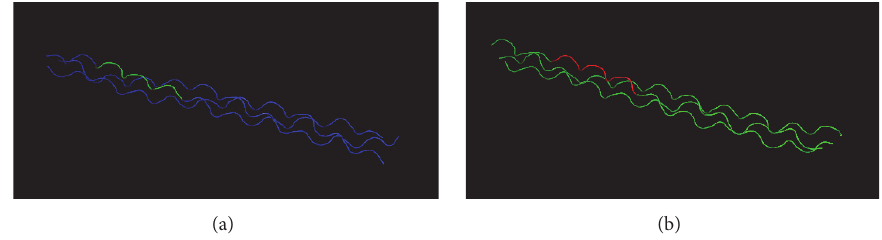
Figure 1: Alfa-1 collagen (a) and Prevotella sp., ZP 05918585.1 (b); according to Swiss-Model these proteins present triple-helix configuration.